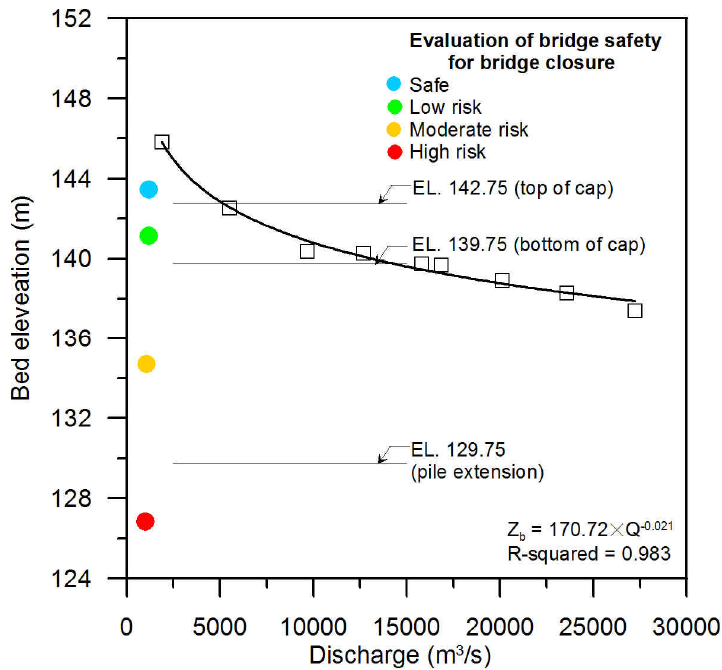
Figure 17. Bridge safety curve (scoured bed level-discharge relationship).